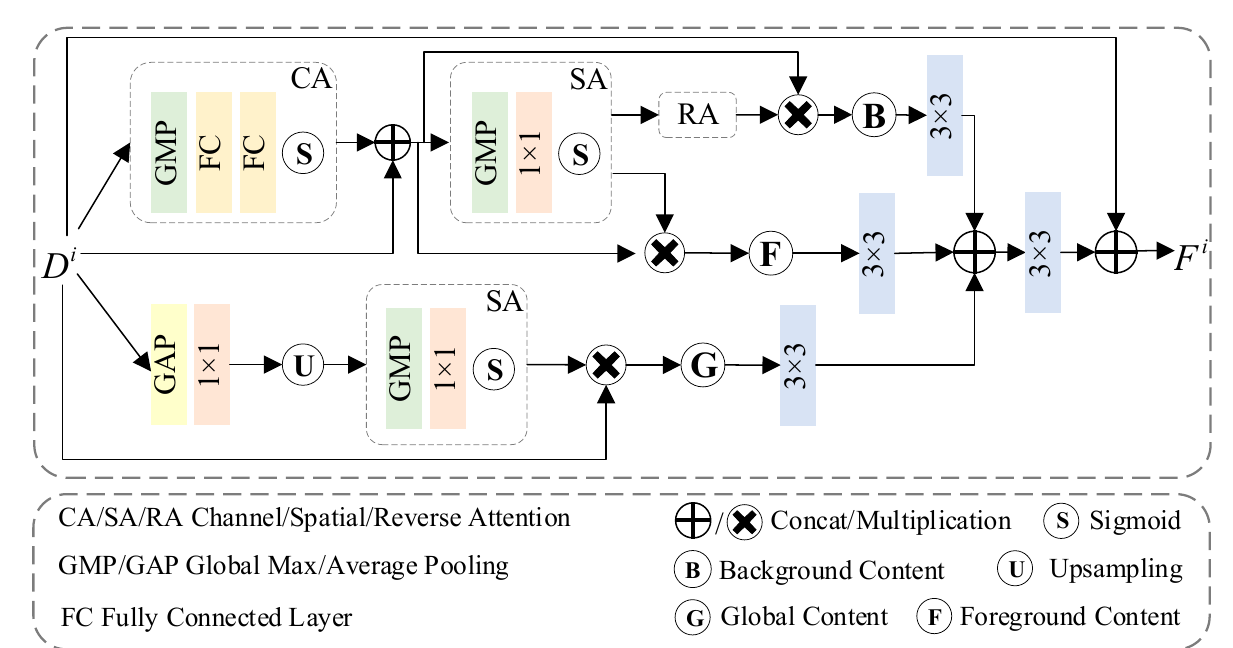
Figure 3. Multi-content fusion module.